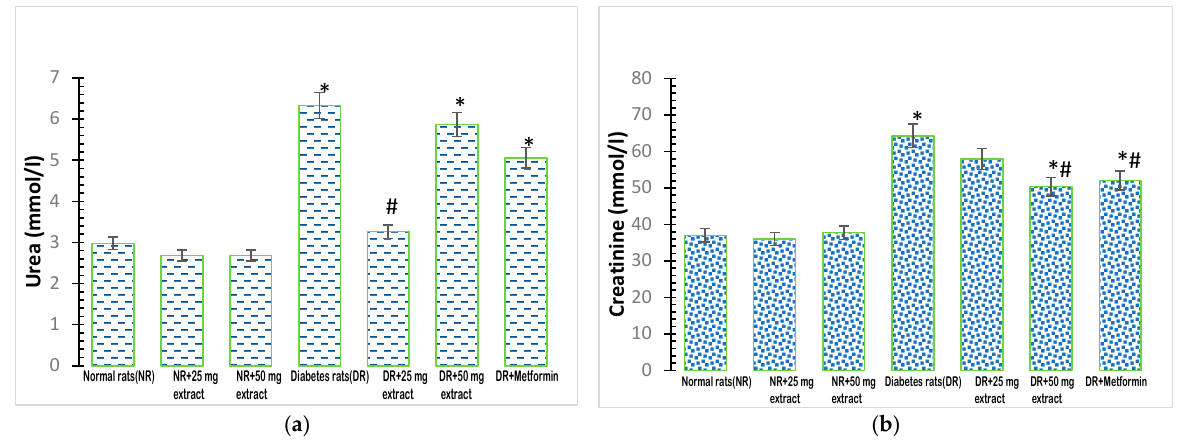
Figure 2. Kidney biomarkers in rats treated with FFMTSE. ( a ) Concentration of urea and ( b ) creatinine in rats treated with FFMTSE. All results are expressed as mean ± SD, (*) indicates a significant difference compared to the normal control group at p < 0.05, and (#) indicates a significant difference compared to the diabetic control group at p < 0.05. FFMTSE: flavonoid-rich fraction of Monodora tenuifolia seed